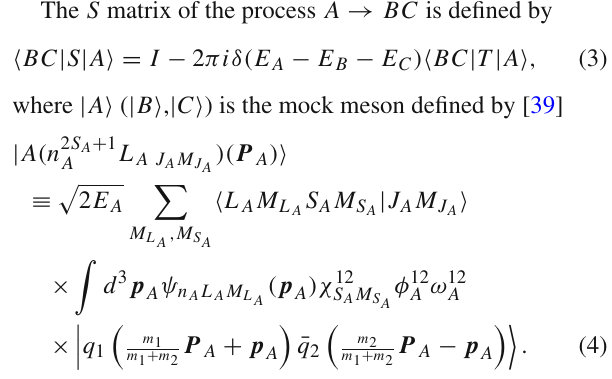
+ ( n − 1 )μ 2 by 0 = 0 = 0 . 30015 ± 0 . 00002 GeV 2 , μ 2 = 0 = 0